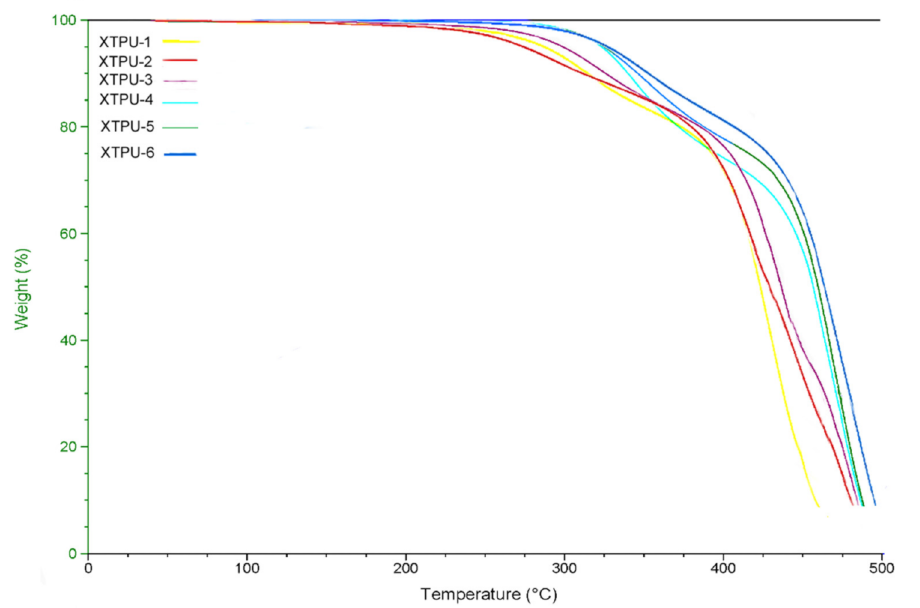
Figure 6. TGA thermogram of XTPUs at 500 ◦ C. Table 2. Thermal stability data of the XTPU samples based on